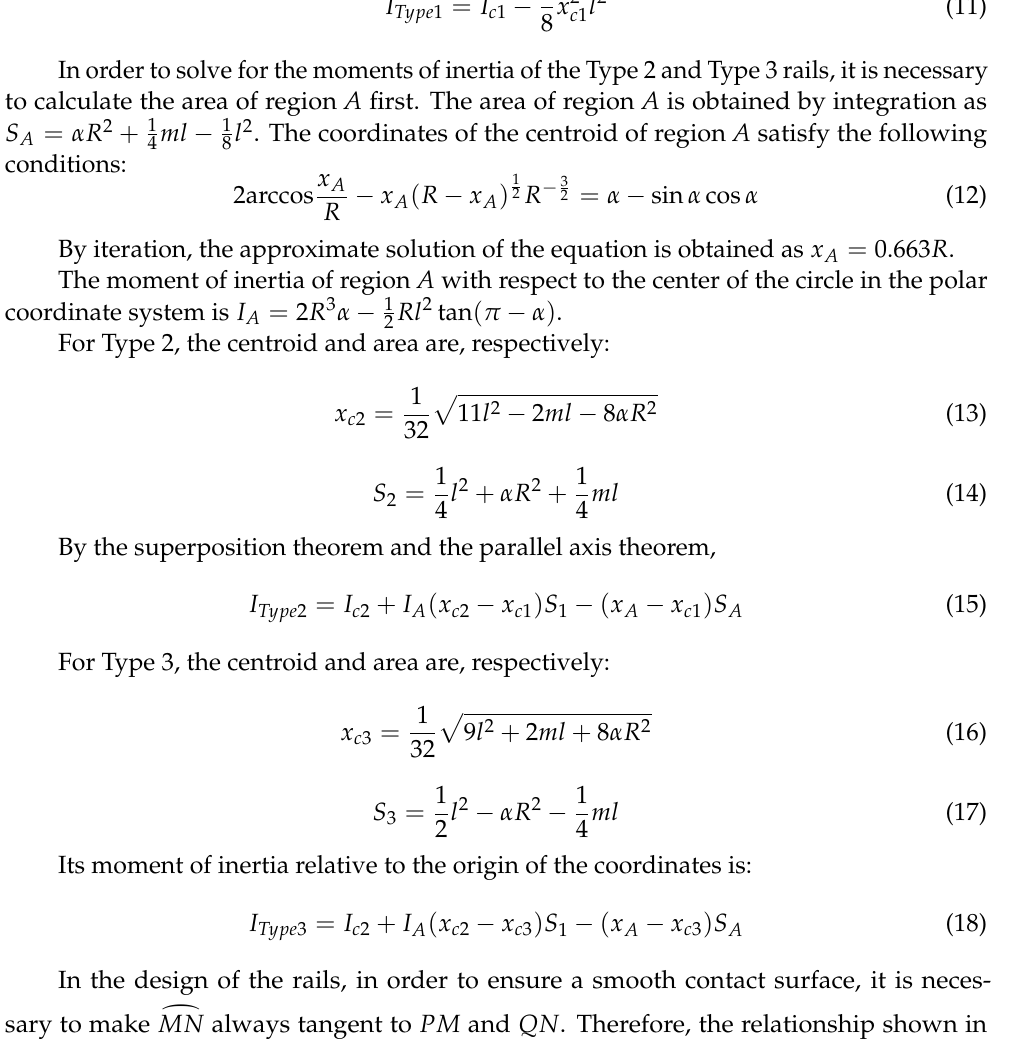
Figure 5. Inertia moment of rails with different parameters. ( a ) Varies vs. m. ( b ) Varies vs. α . Obviously, for the three types of rails studied in this paper, the convex rail (Type 2) has the best resistance to bending. Figure 6 shows the deformation of the three types of rails after armature assembly. Figure 7 shows the Von Mises stress distribution of the three rails after armature assembling. It can be seen that the deformation of the convex rail is much smaller than the other two rails, which is consistent with the calculated results of the moment of inertia. In addition, the stress accumulation on the convex rail is smaller, indicating that the convex orbit has a longer lifetime under repeated firing conditions. Figure 6. Deformation of three different rails. Figure 7. Von mises Stress distribution on the rails.